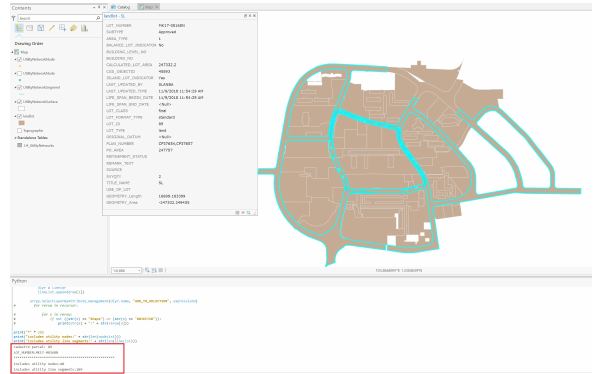
Figure 11. Visualization of underground utilities with land parcel and cadastral